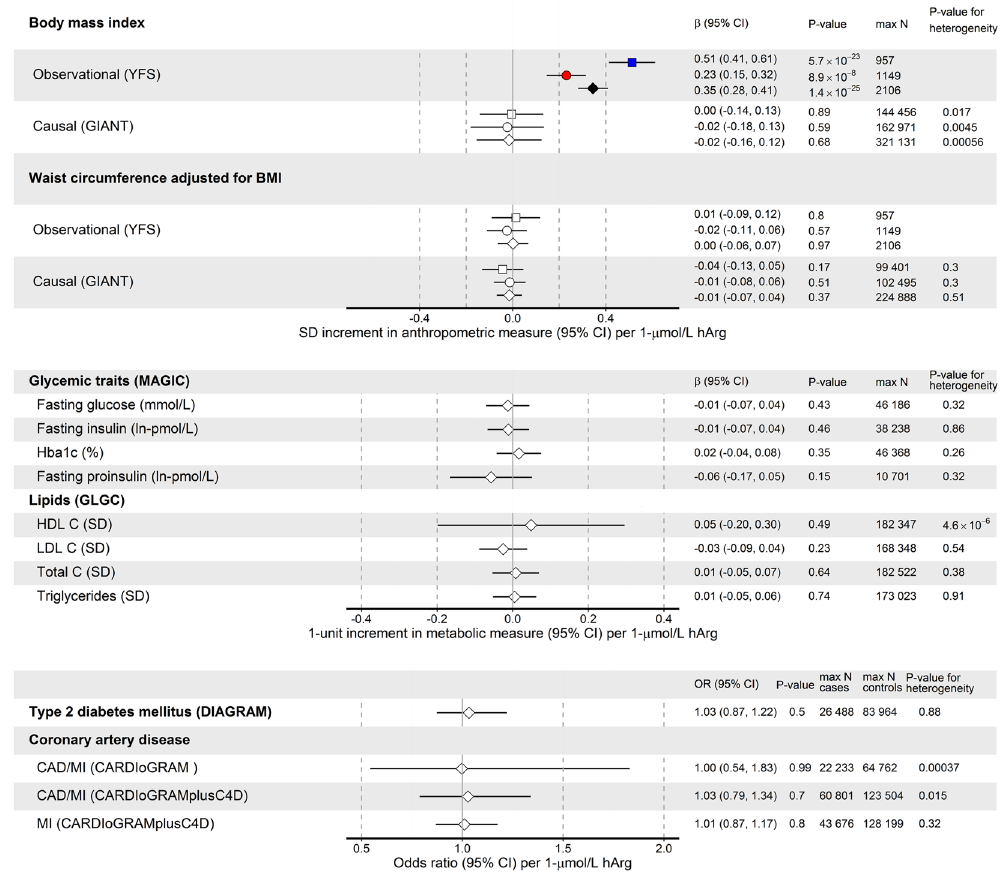
Figure 4. Combined causal effect estimates ( β = beta, odds ratio and 95% CI confidence intervals) of hArg with cardiometabolic risk factors, type 2 diabetes mellitus (T2DM) and coronary artery disease (CAD). For each metabolite, the summary-level data across the three hArg-associated SNPs ( GATM rs1153858, CPS1 rs1047891 and AGXT2 rs37369) was combined using weighted linear regression, and the heterogeneity in the causal effects from different individual variants was tested by Cochran’s Q statistic. All p-values for combined causal effects > 0.05. A p-value of > 0.05 from Cochran’s Q statistic indicates that there is no more heterogeneity between causal effects estimated using the variants individually than would be expected by